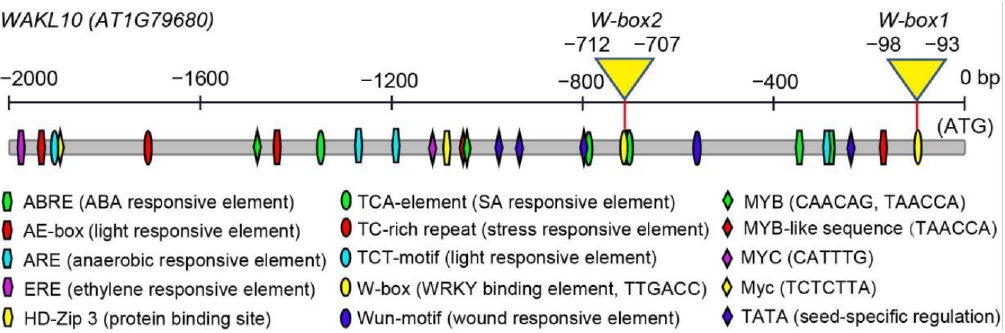
Figure 7. Analysis of the promoter of AtWAKL10 . Schematic diagram of the promoter region of AtWAKL10 showing various stress responsive cis elements and transcription factors binding sites. The positions of two W-box motifs are indicated by yellow solid